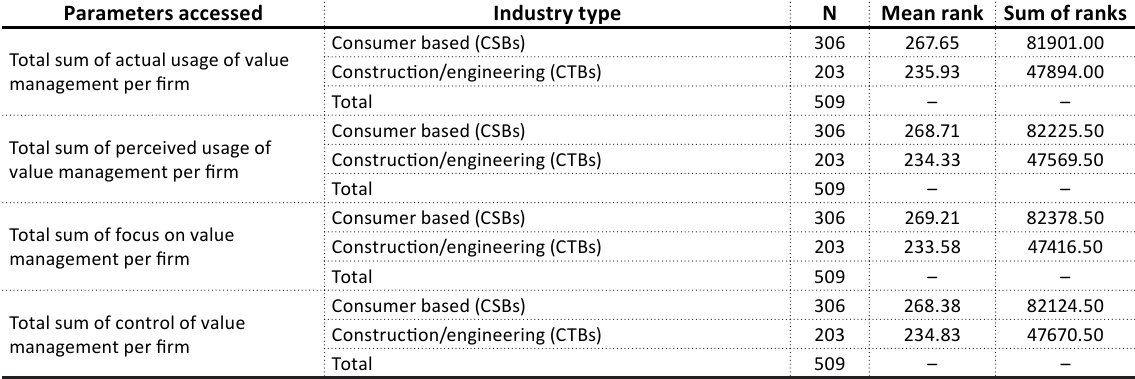
Table 8. Mann-Whitney U result on group difference